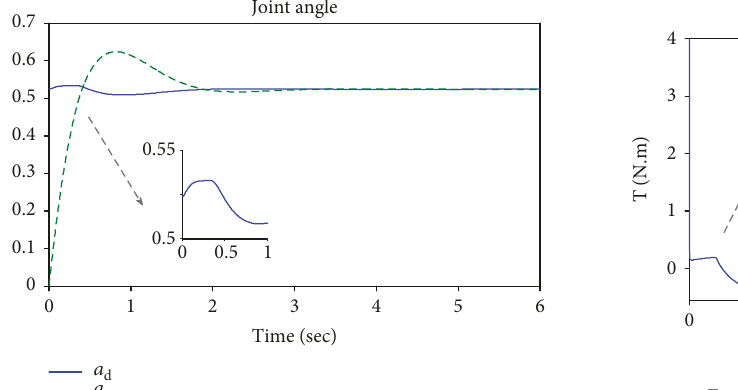
Figure 23: Joint torque for the